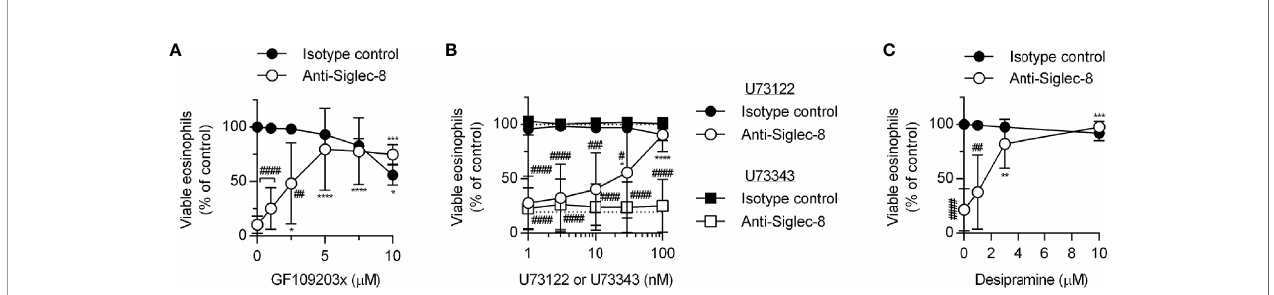
FIGURE 5 | The PLC-PKC signaling axis and sphingomyelin metabolism are necessary for Siglec-8 – induced eosinophil cell death. Peripheral blood eosinophils were stimulated with 30 ng/ml IL-5 overnight and pretreated with the indicated concentration of the PKC inhibitor GF109203x (A) , the PLC inhibitor U73122 (circle symbols) or pharmacologically inactive analog U73343 (square symbols) (B) , or the functional acid sphingomyelinase and acid ceramidase inhibitor desipramine (C) for 30 min prior to 18 – 24-h treatment with anti-Siglec-8 (open symbols) or isotype control mAb ( fi lled symbols). Cell viability was then assessed by annexin V/DAPI staining by fl ow cytometry. Dotted lines indicate viability levels with no pharmacological inhibition for inhibitors plotted on a logarithmic scale. Plots represent the mean percentage of viable eosinophils normalized to the viability of untreated eosinophils ± standard deviations for 3 independent experiments. *p < 0.05, **p < 0.01 ***p < 0.001, ****p < 0.0001 relative to within – antibody stimulation group vehicle control sample. # p < 0.05, ## p < 0.01, ### p < 0.001, #### p < 0.0001 relative to isotype control sample at the same pharmacological inhibitor concentration.